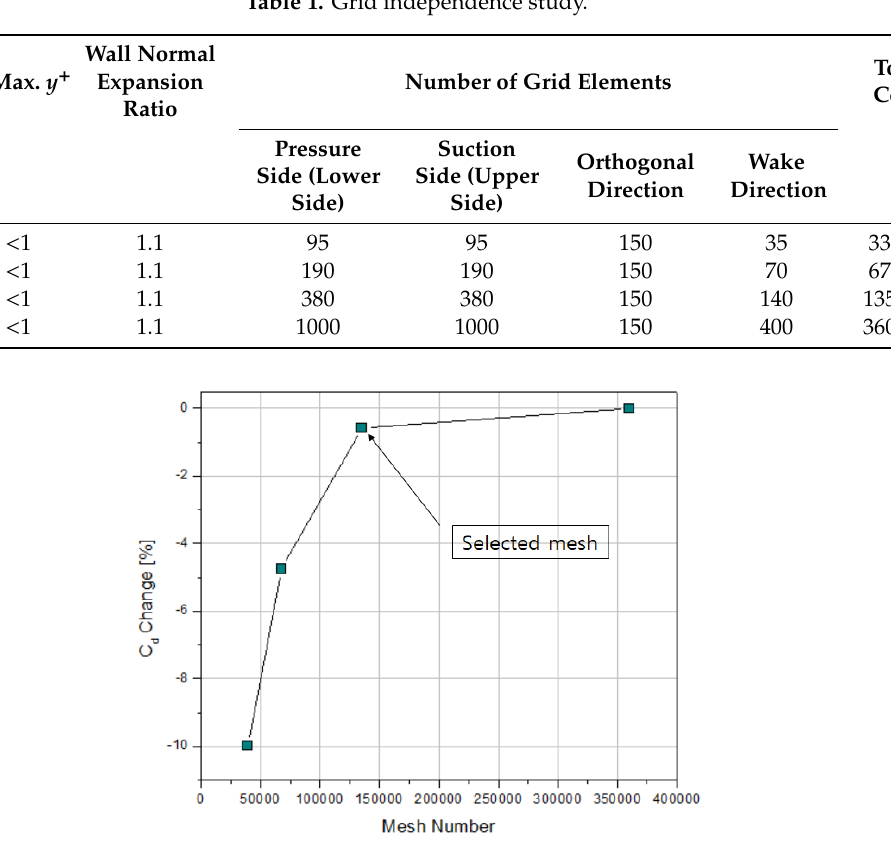
Figure 5. C d percent change based on C d = 0.006497 for the finest mesh (Grid 4) at each calculation as a function of mesh resolution for the NREL S809 airfoil with AoA = 0° and Re = 2 × 10 6 .